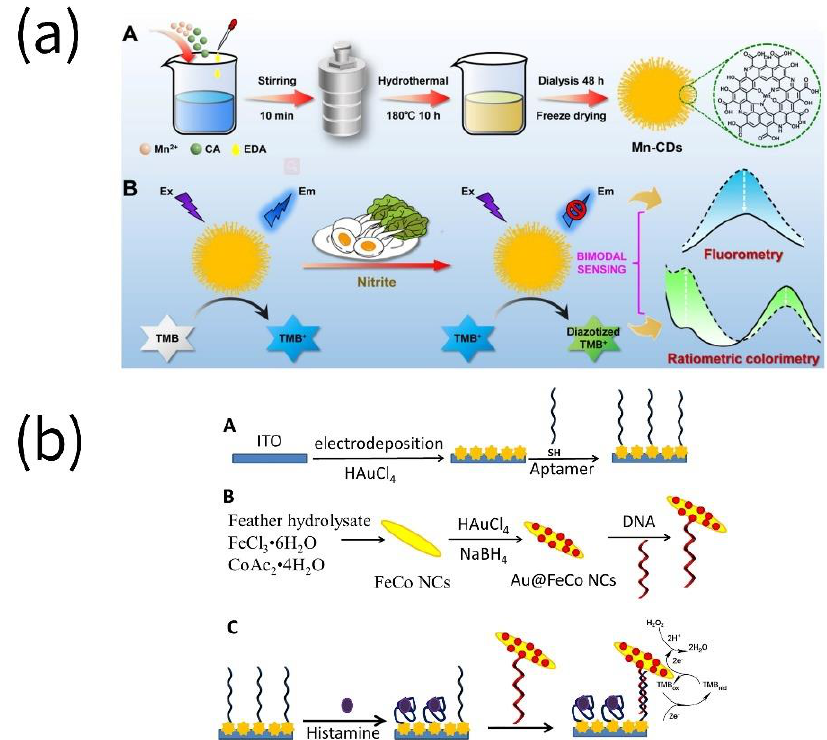
Figure 6. Assays for the detection of other food hazard substances in food by nanozymes. ( a ) Nitrite was detected using Mn-doped N-rich carbon dots (Mn-CDs) (reprinted with permission from [78], Copyright 2022, American Chemical Society). ( b ) Histamine was detected using DNA/Au@FeCo nanoflowers (NCs) (reprinted with permission from [74], Copyright 2022, Elsevier).